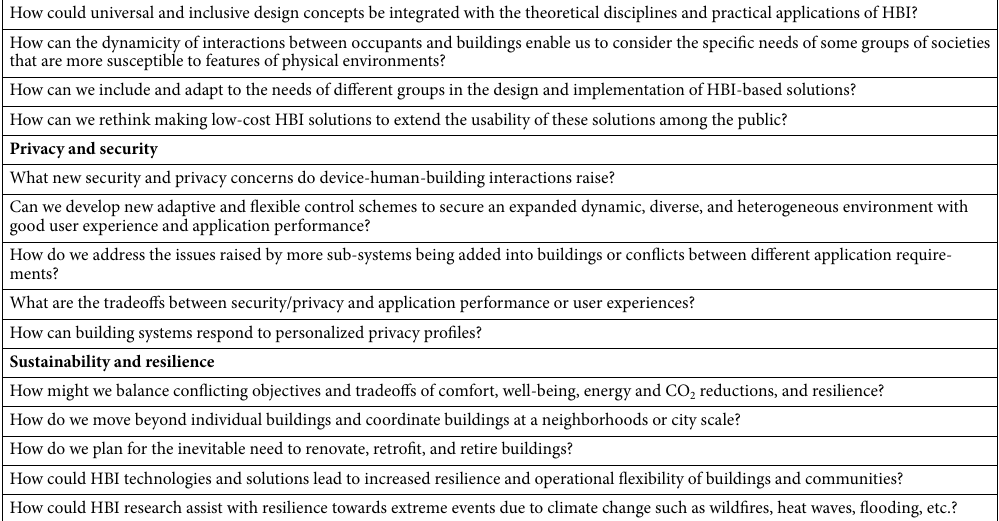
Table 3. Sample research questions related to core principles of